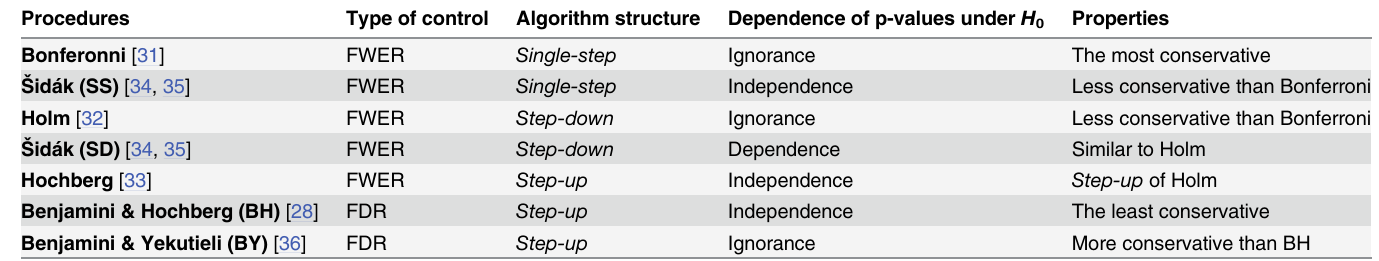
Table 2. Properties of the multiple testing